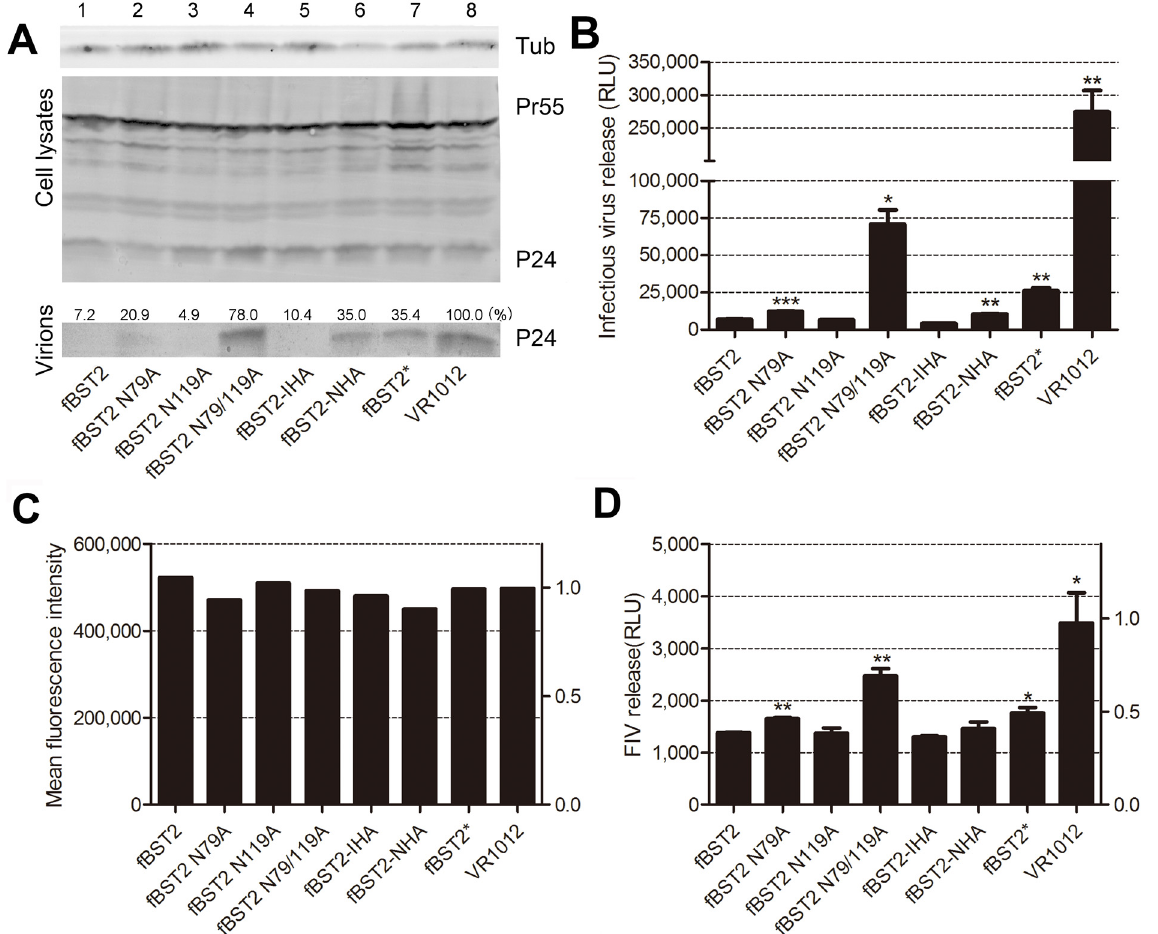
Fig 4. Effect of BST2 variants on HIV-1 virus and FIV pseudovirus particle release. (A) Twenty-five nanograms of fBST2, fBST2 N79A, fBST2 N119A, fBST2 N79/119A, fBST2-IHA, fBST2-NHA, fBST2 * or the VR1012 control vector was co-transfected with 1 μ g of the proviral plasmid pNL4-3 WT in 293T cells. At 48 h post-transfection, cultured supernatants were ultracentrifuged to concentrate the virus particles. Virions and cell lysates were analyzed by Western blotting using an anti-p24 antibody to detect viral p24 and intracellular Pr55Gag proteins, as well as an antibody against tubulin to assess sample loading. The blots of released p24CA were quantified using Bandscan software and normalized by tubulin levels. (B) Titration of the released infectious viruses in A is shown in columns, which are representative of three independent experiments and expressed as relative luciferase units (RLU). (C) VR1012, fBST2, fBST2 N79A, fBST2 N119A, fBST2 N79/119A, fBST2-IHA, fBST2-NHA or fBST2 * (25 ng each) was co-transfected with 1 μ g of FIV- Δ Vif- Δ OrfA- Δ Env-GFP reporter virus plasmid (pFP93: pGINSIN: pVSV-G = 3:3:1) in CrFK cells. Forty-eight hours later, the cells were harvested and analyzed for fluorescence intensity by flow cytometry as an expression control. (D) Supernatants from producer cells were harvested, clarified and assayed for GFP fluorescence intensity using a fluorescence microplate reader to represent released virus yield. This experiment was repeated three times. * P < 0.05; ** P < 0.01; *** P < 0.001 compared to